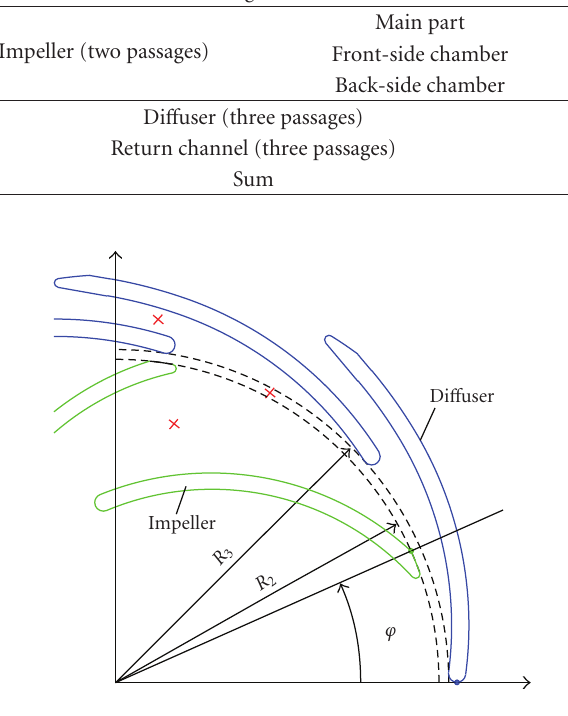
Figure 2: Definition of rotating